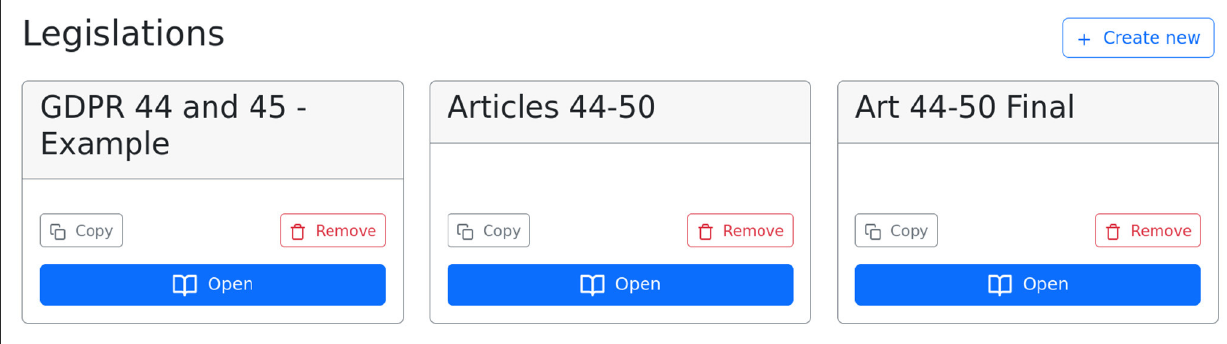
FIGURE1 Dashboard for creating and editing legislations.